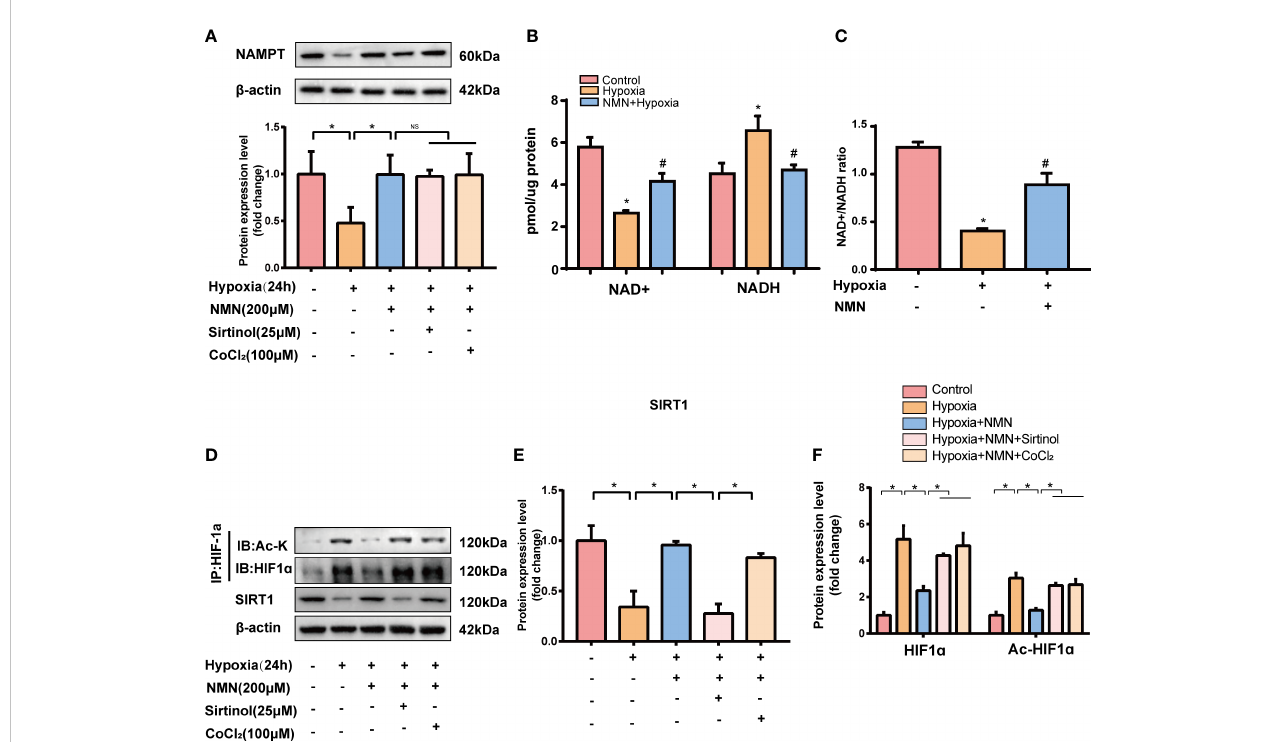
FIGURE 4 NMN restores NAMPT/NAD+/SIRT1 axis and inhibited HIF-1 a acetylation in SVF cells. (A) The relative protein levels of NAMPT normalized to b -actin in SVF cells (n = 3). (B, C) Statistical results for NAD + /NADH contents and NAD + /NADH ratio in SVF cells (n = 3). (D – F) The relative protein levels of SIRT1 and HIF1 a in SVF